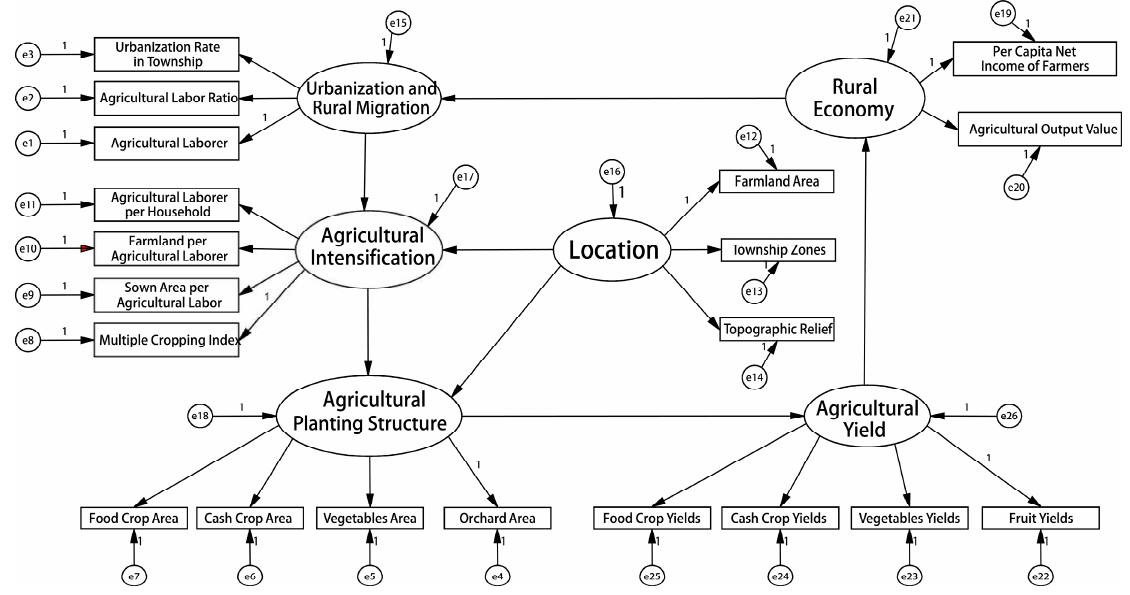
Figure 10. Linkage analysis framework of rural–urban transition and agricultural restructuring.